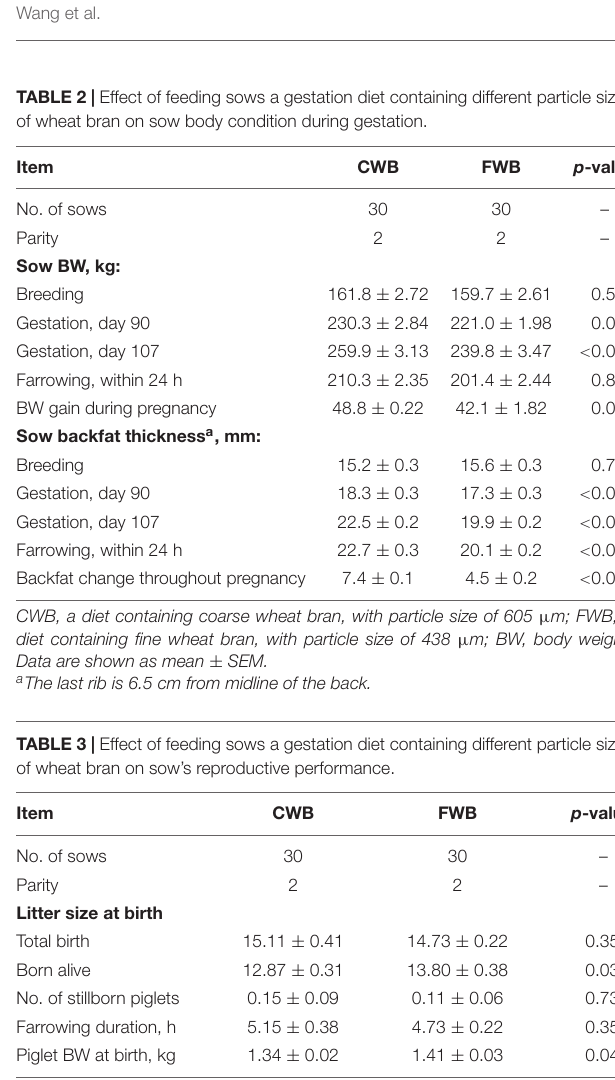
Figure 1A ). The relative abundance of Ruminococcaceae_UCG-